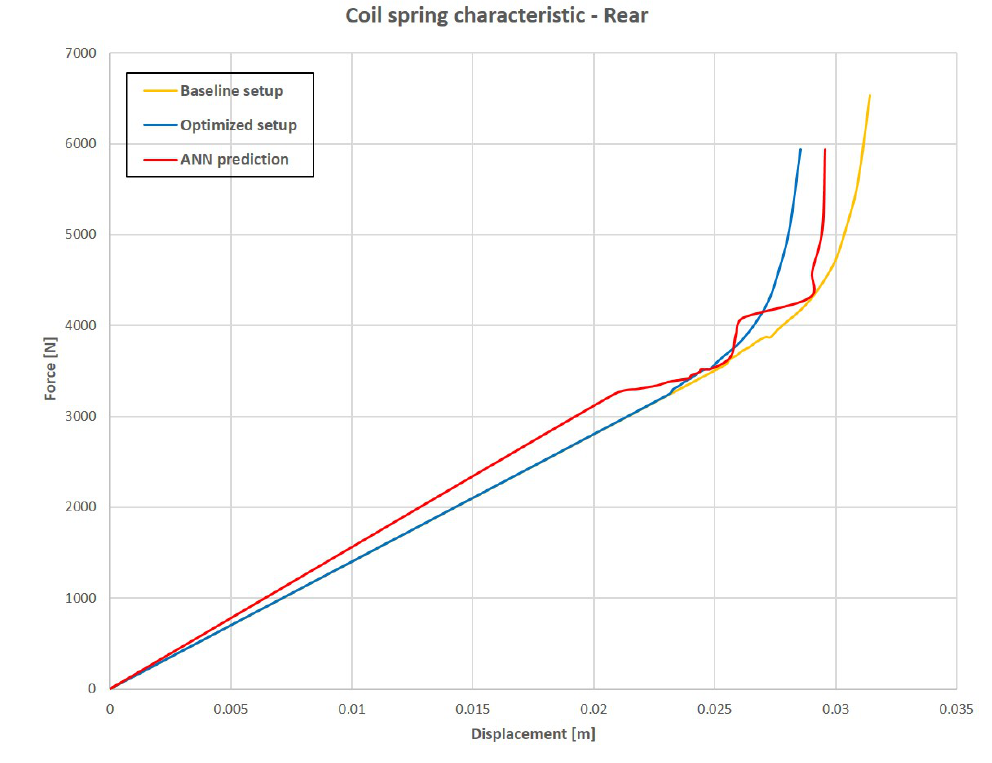
Figure 32. Rear spring characteristic comparison.